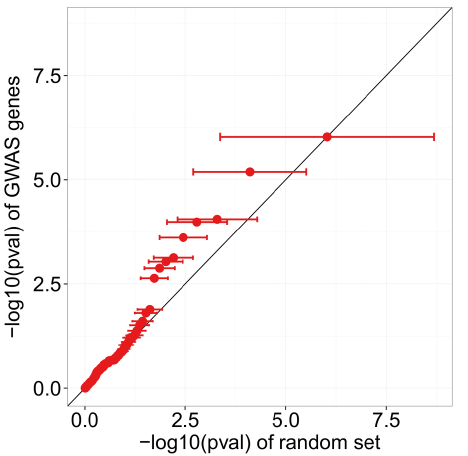
Figure 3. GWAS genes identified from validated SNPs appear to be enriched for differential expression. X -axis values of dots indicate the mean 2 log10(pval) from 10,000 randomly permuted sets, and error bars indicate one standard deviation from the mean in these permutations.